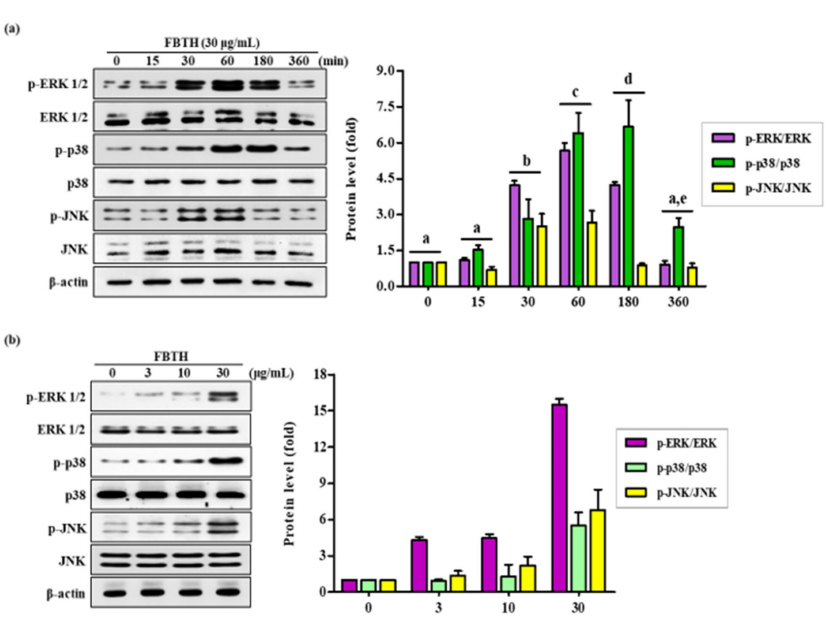
Figure 5. Effects of the FBTH on the expression of ERK/p38/JNK phosphorylation in Melan-A cells. Cells (1 × 105 cells/mL) were cultured with FBTH (3, 10, and 30- µ g/mL) for 72 h, and the protein levels were analyzed by Western blotting ( a , b ). The statistical analysis of protein band density was shown in the adjacent figure in a time ( a ) or concentration ( b )-dependent manner. NT: No treatment. Data are expressed as the mean ± SD ( n = 3). All tests were performed in triplicate. Different letters stand for statistically significant each other ( p < 0.05) performed by one-way ANOVA followed by Tukey’s